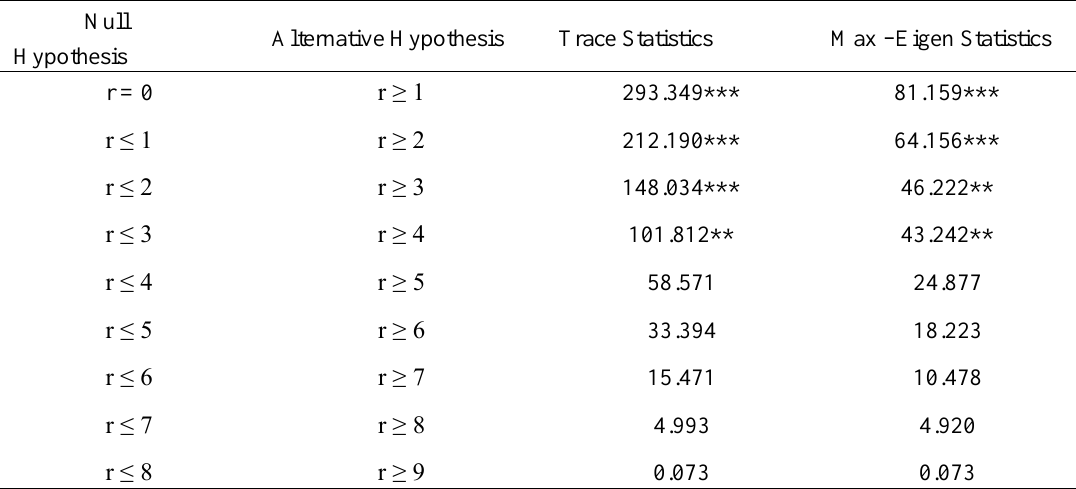
Table 3: The Results of Johansen Cointegration